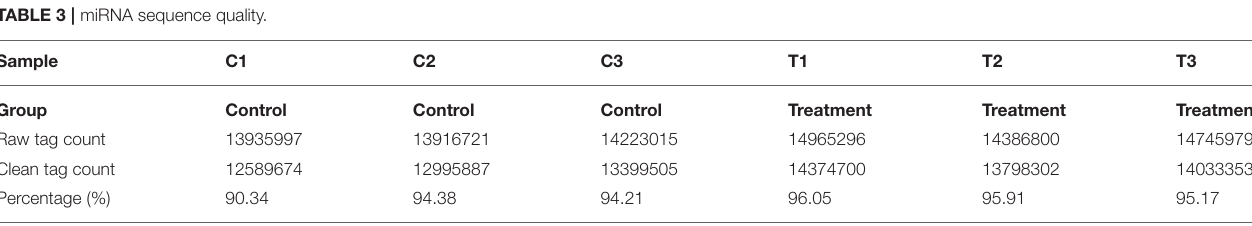
TABLE 3 | miRNA sequence